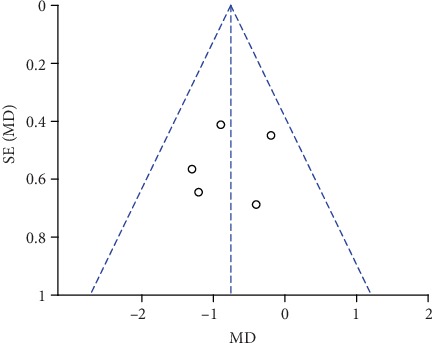
Funnel plot of pain scores at rest at 2 h.